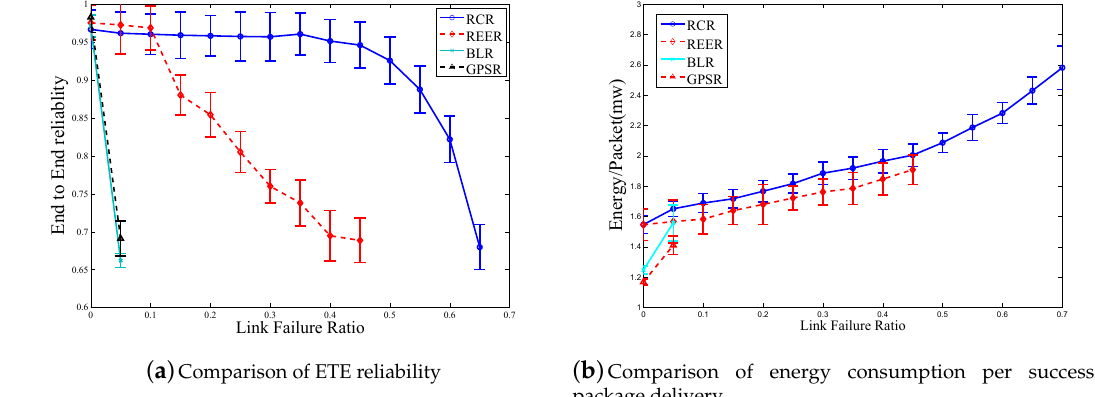
Figure 9. Comparison of ETE reliability and energy consumption with